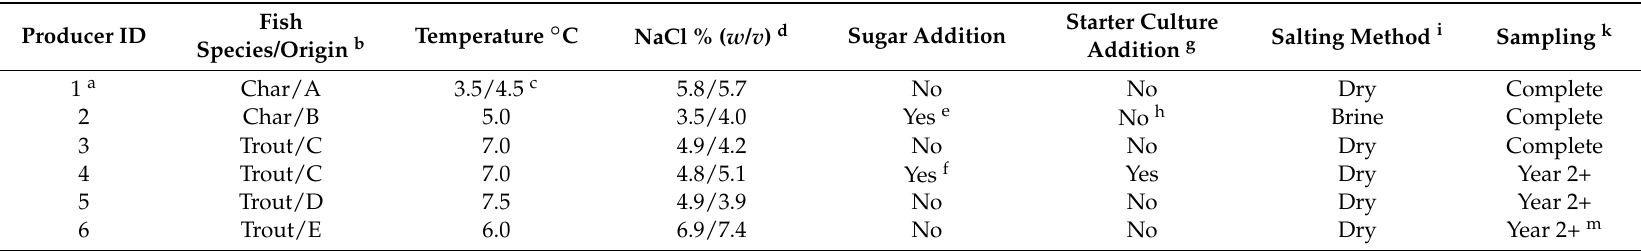
Table 1. Different parameters used during the production of rakfisk in this study. (The temperatures were measured and given by the individual manufacturers). Producer ID